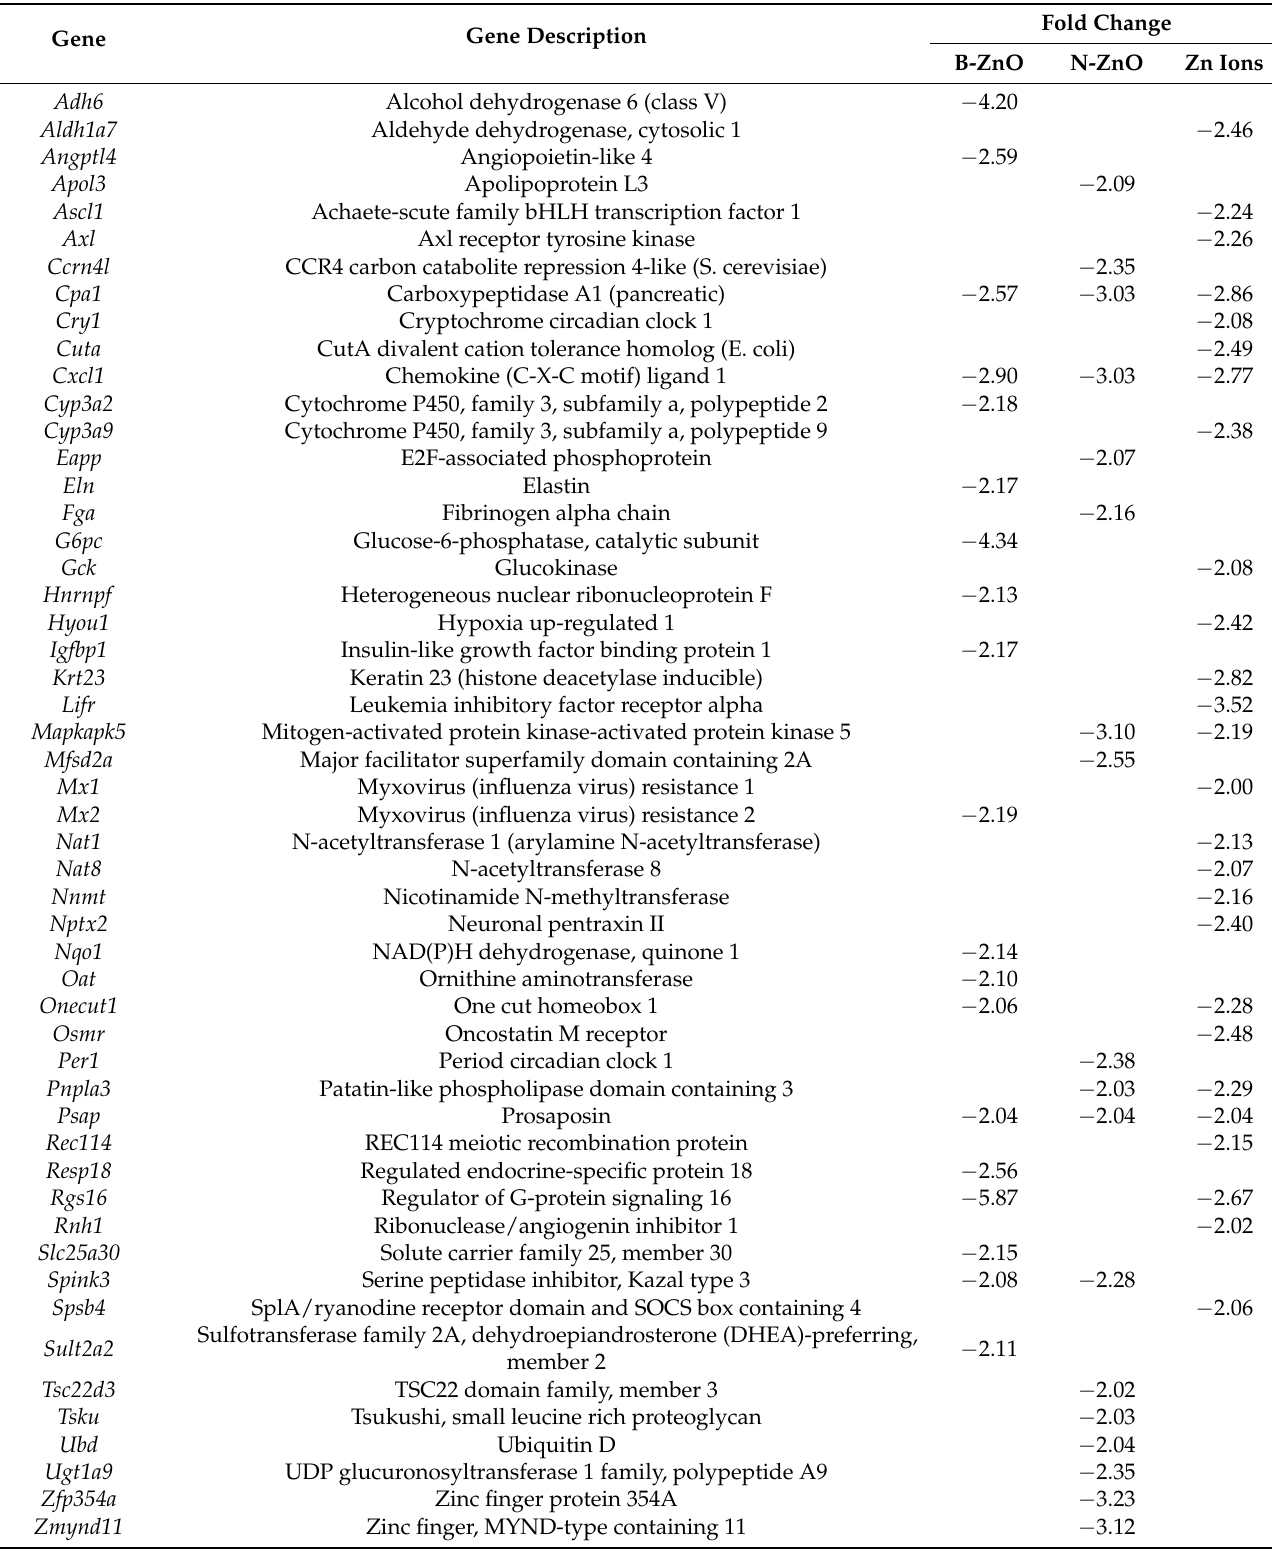
Table 5. Two-fold down-regulated differentially expressed genes (DEGs) compared with non-treated control in the livers after 14-day repeated oral administration of B-ZnO, N-ZnO or Zn ions in rats.